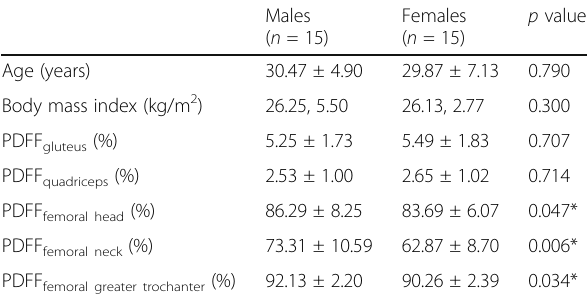
Table 1 Study population